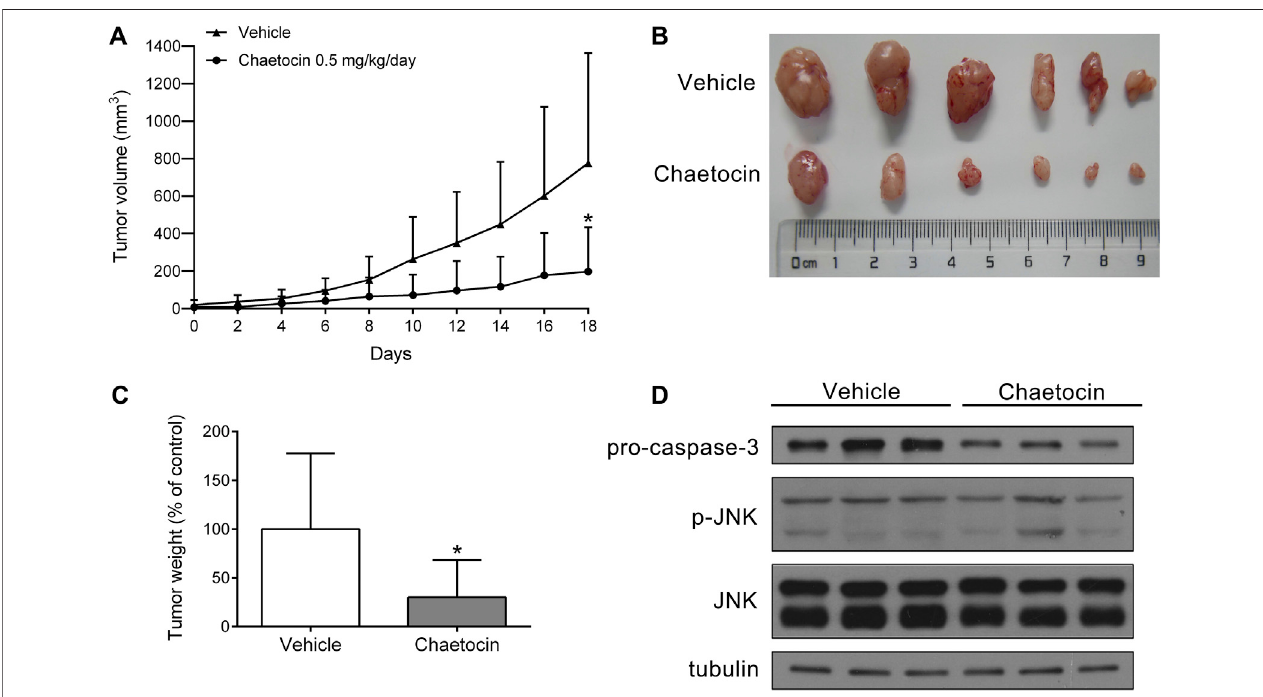
FIGURE 8 | Chaetocin inhibits the growth of CRC cell xenografts. Nude mice subcutaneously inoculated with HCT116 cells were subjected to chaetocin (0.5 mg/kg/day) treatment for 18 days, control group was treated with vehicle. (A) Tumor growth curves were recorded every other day. (B) and (C) The image of tumor tissueattheendoftheexperiment. (D) Theproteinlevelsofpro-caspase-3andJNKintumortissuesweredetectedbywesternblot.For (A) and (C) ,resultswereshown as mean ± SD of six mice in each group. * p < 0.05, versus vehicle group.